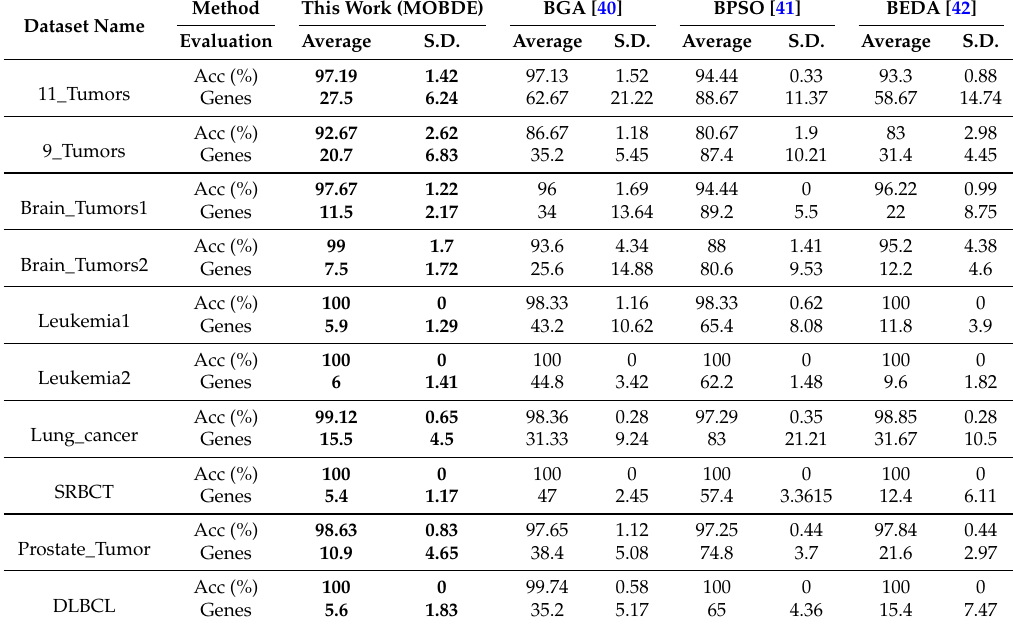
Table 8. Comparative experimental results of the binary differential evolution algorithm with the binary genetic algorithm, binary particle swarm optimization and the binary estimation of binary estimation of distribution algorithm.